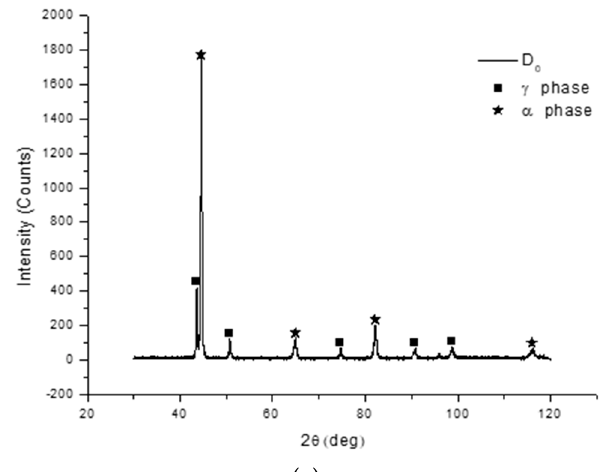
Figure 3. High magnification (1000×) optical ( a , b , c ) and scanning electron microscope (SEM) (4000×) ( d , e , f ) micrographs of the D 0 specimen in ( a , d ) D d1 in ( b , e ) and D c1 in ( c , f ) showing elongated grains inside the melting pool ( a , b , c ) with some traces of boundary phase distributed also in the inner of the melting pool ( c , d , e ).